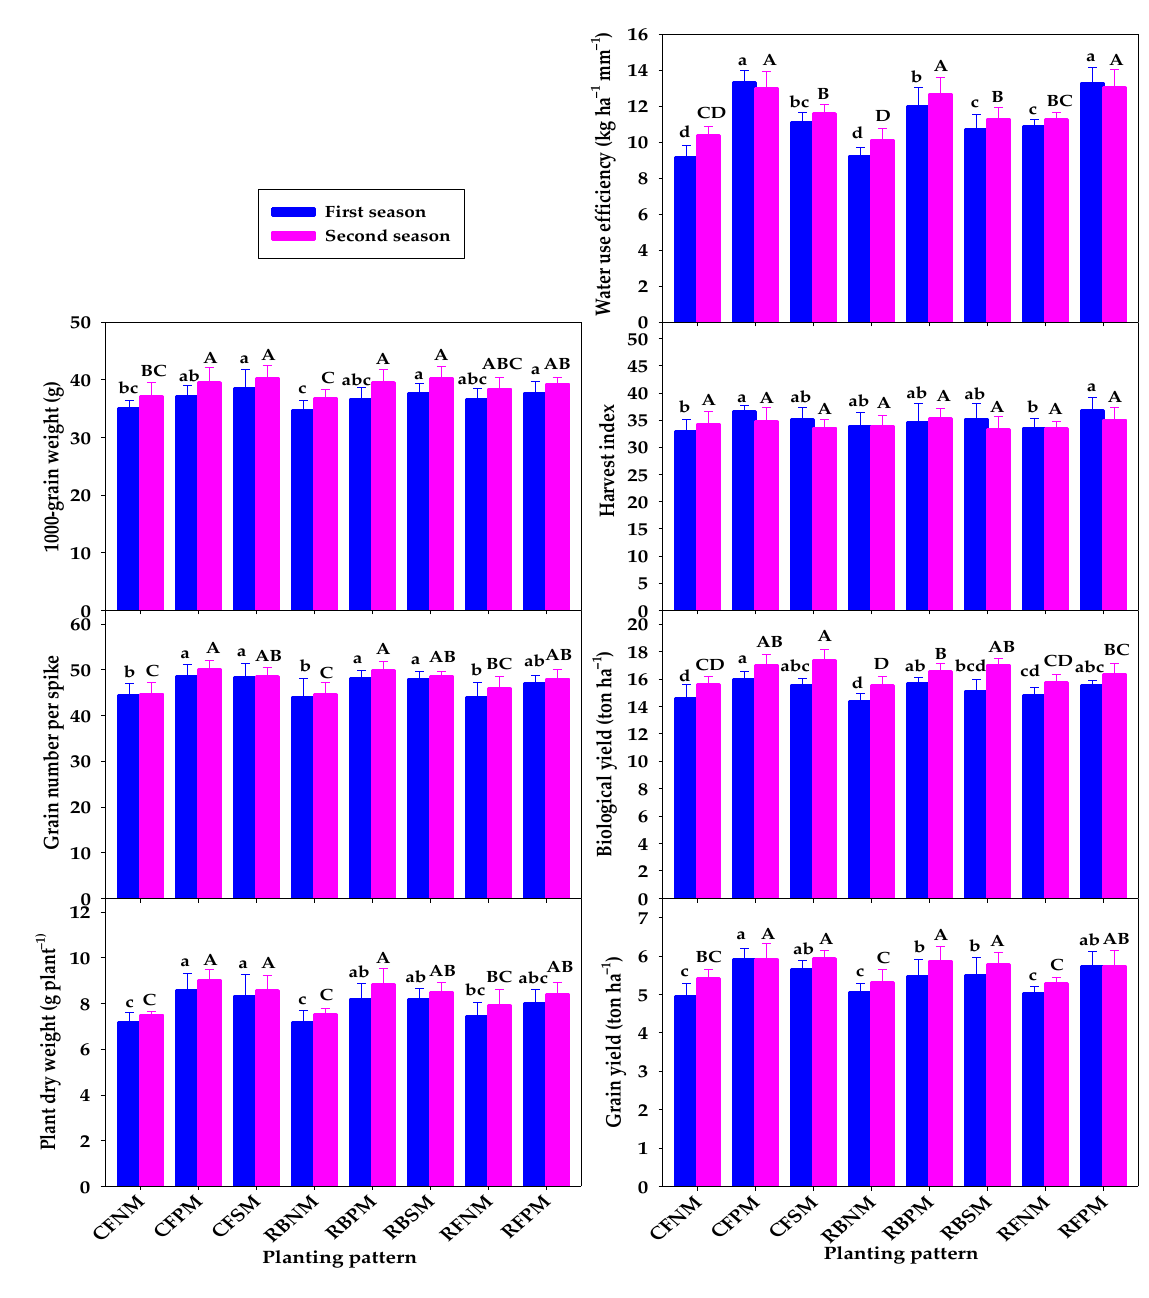
Figure 6. Effects of different combination of planting patterns (PP) and mulching on all measured parameters in the first and second seasons. Conventional flat planting (CF) without mulching (CFNM); CF with plastic film mulch (CFPM); CF with wheat straw mulch (CFSM); raised-bed planting (RB) without mulch (RBNM); RB with plastic film mulch (RBPM); RB with wheat straw mulch (RBSM); ridge–furrow planting (RF) without mulch (RFNM); and RF with plastic film mulch on both ridges and furrows (RFPM). Means followed by the same lowercase letter are not significantly different between eight PP in the first season at p = 0.05 according to Duncan’s multiple range test. Means followed by the same uppercase letter are not significantly different between eight PP in the second season at p = 0.05 according to Duncan’s multiple range